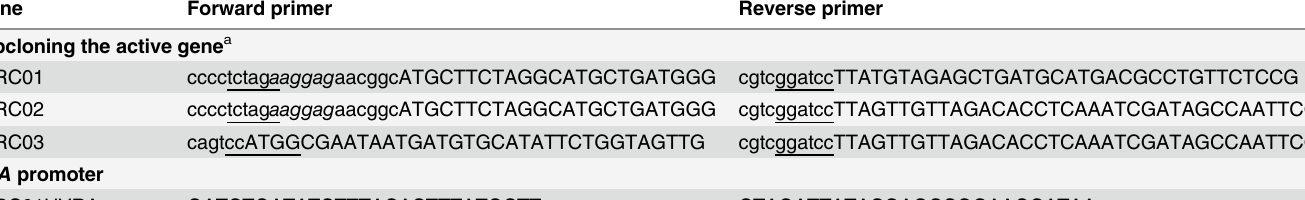
Table 2. Primers (5 0 -3 0 ) used for cloning and qPCR/RT-PCR.